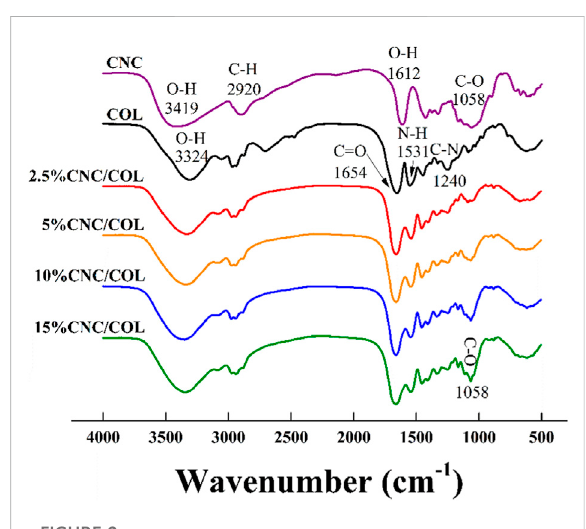
FIGURE 2 FTIR spectrogram of CNC/COL hydrogels with different CNC